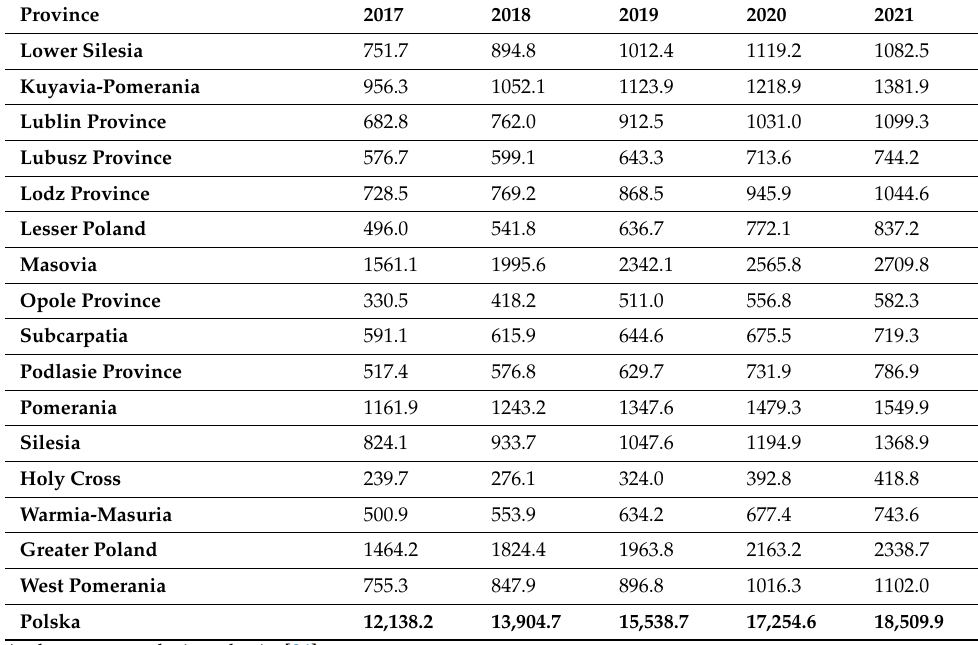
Table 1. Bicycle roads in Poland in